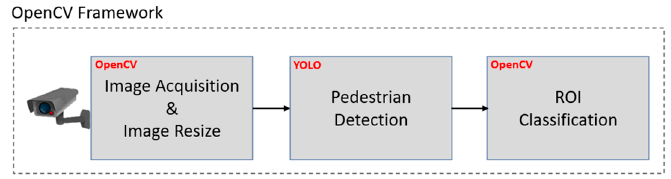
Figure 7. Pedestrian Detection blocks organization.